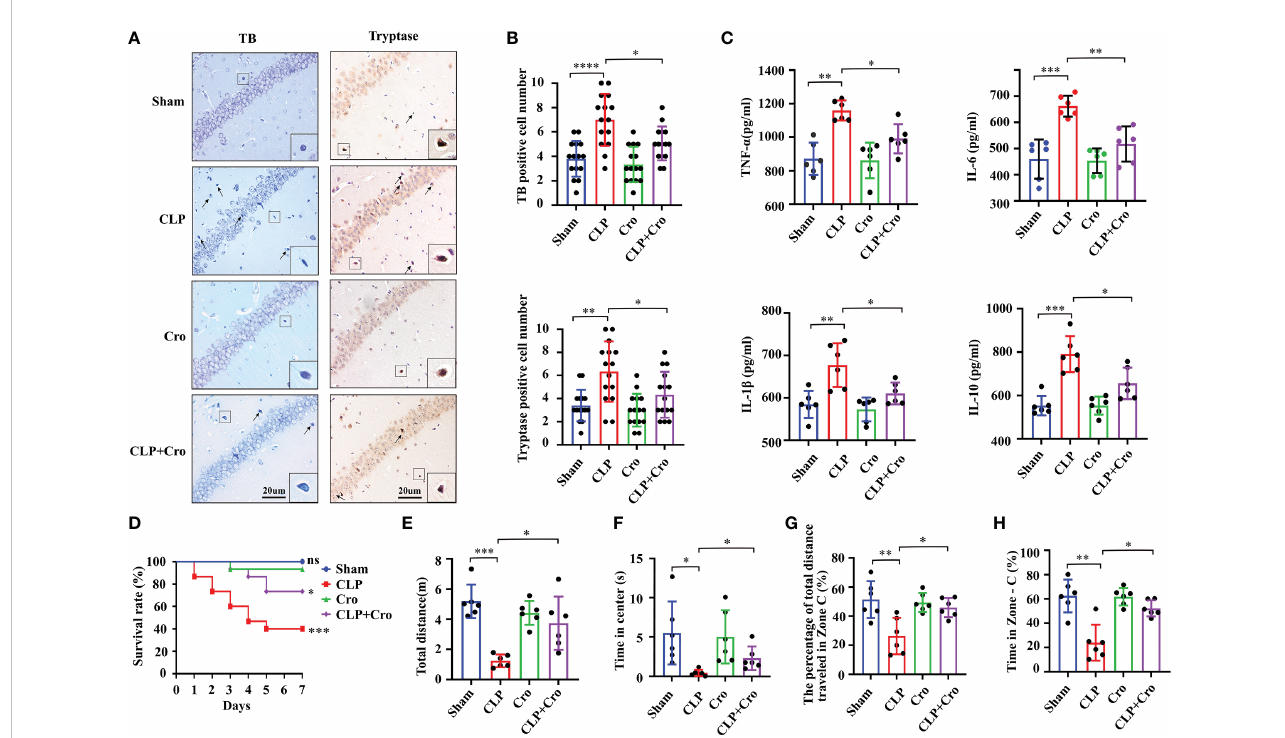
FIGURE 2 Cromolyn defended neuroin fl ammation, improved SAE mice survive, and alleviated cognitive impairment. (A) Cromolyn inhibited MCs activation in the CA1 region of the hippocampus by TB staining and tryptase IHC staining (n=6). (B) Quanti fi cation of TB- and tryptase-positive cells (n=6). (C) ELISA test showed that cromolyn decreased the levels of TNF- a , IL-6, IL-1 b and IL-10 in hippocampus tissue (n=6). (D) Cromolyn treatment improved 7-day survival rate in septic mice (n=15). The total movement distance (E) and the time in center (F) in the open fi eld test, and the movement distance (G) , and the time (H) in zone C in the Y maze test were increased after cromolyn treatment (n=6). MCs, Mast cell; CLP, Cecal Ligation and Puncture; SAE, Sepsis- associated encephalopathy; TB, Toluidine blue; IHC, immunohistochemistry; (ns, no signi fi cance, * p < 0.05, ** p < 0.01, *** p < 0.001, **** p <